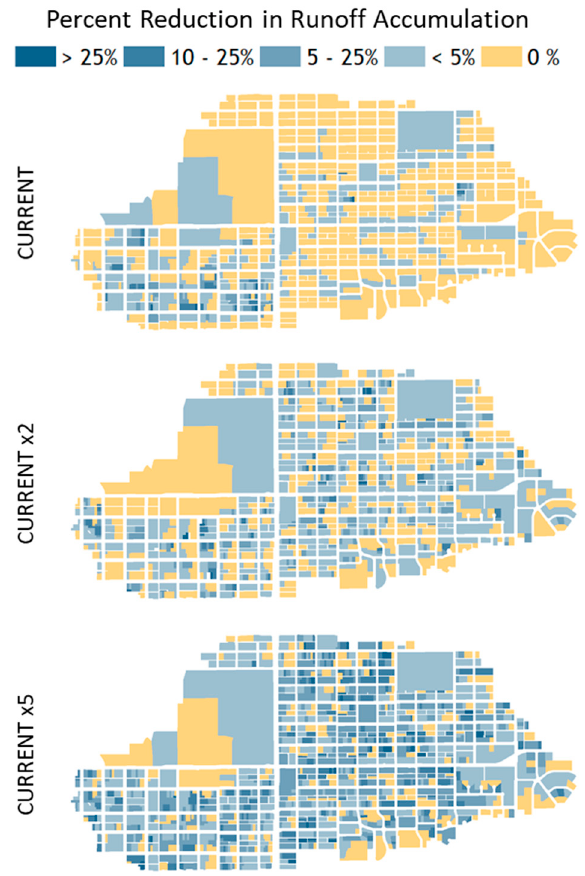
Figure 5. Spatial comparison of the percent reduction in runoff accumulation on the street half for configurations CURRENT ( top ), CURRENT × 2 ( middle ), and CURRENT × 5 ( bottom ) as compared to the NO GI configuration for the 25-year design storm event. RB: On-street basins. RRH: Roof runoff harvesting